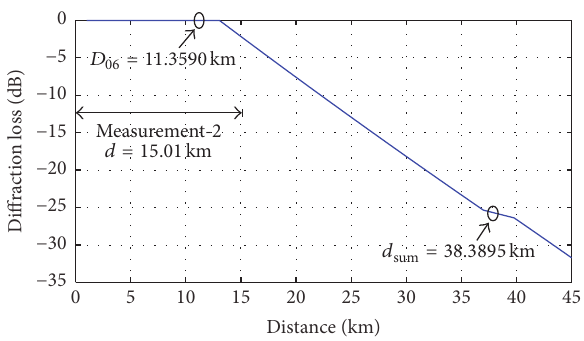
Figure 23: Diffraction loss caused by earth curvature in the case of measurement data 2.